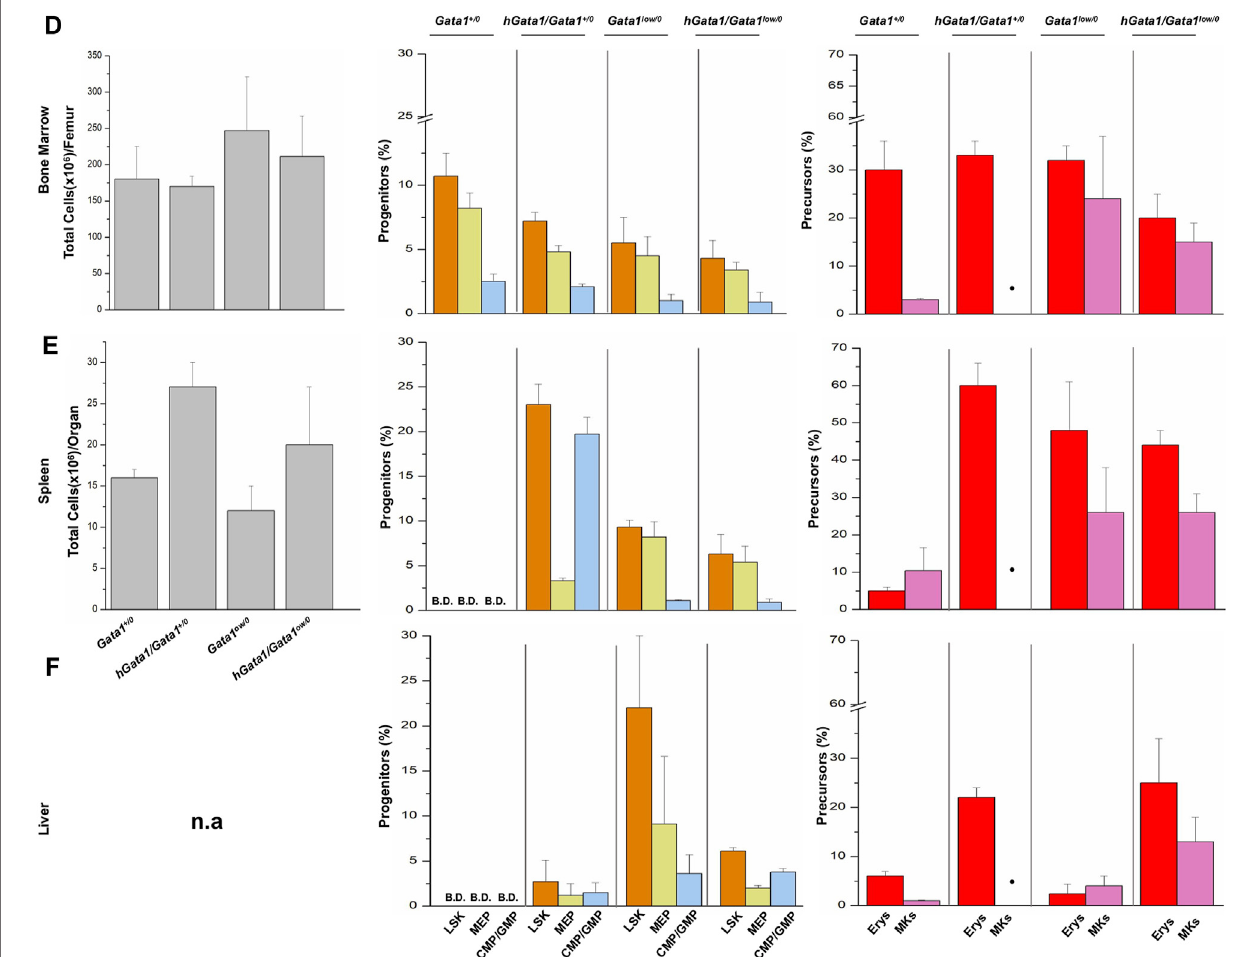
FIGURE 5 | The presence of hGATA1 increases the frequency of hematopoietic cells in the bone marrow and liver of Gata1 low/0 mice and in the liver of wild type (Gata1+/0) mice. (A – C) Gates used to identify GMP/CMP and MEP, erythroblasts and megakaryocytes in organs from representative Gata1 +/0 , hGATA1/Gata1 +/0 , Gata1 low/0 and hGATA1/Gata1 low/0 mice are indicated in panel (A – C) , respectively. The numbers on the top of the gates indicate the frequency of the cell population in that particular experiment. (D – F) Total cell numbers (left panels) and frequency of stem/progenitors cells (LSK, Lin − /CD117 pos /Sca1 pos , CMP/GMP, CD117 pos / CD34 pos ,MEP,CD117 pos /CD34 neg )(middlepanels)andoferythroid(Erys,TER119 pos /CD71 pos )andmegakaryocyte(MKs, CD41 pos /CD61 pos )precursors(rightpanels) in the femur (D) , spleen (E) and liver (F) from Gata1 +/0 , hGATA1/Gata1 +/0 , Gata1 low/0 and hGATA1/Gata1 low/0 mice. Results are expressed as Mean ( ± SD) of those obseved with 3 mice per experimental group. Statistical analyses was performed by One-way analysis of variance Tukey Multiple Comparison Test. Results of the statistical analyses: Bone marrow (cid:2) total cell number: Gata1 +/0 vs hGATA1/Gata1 +/0 p < 0.05 and hGATA1/Gata1 +/0 vs. Gata1 low/0 p < 0.01; LSK: Gata1 +/0